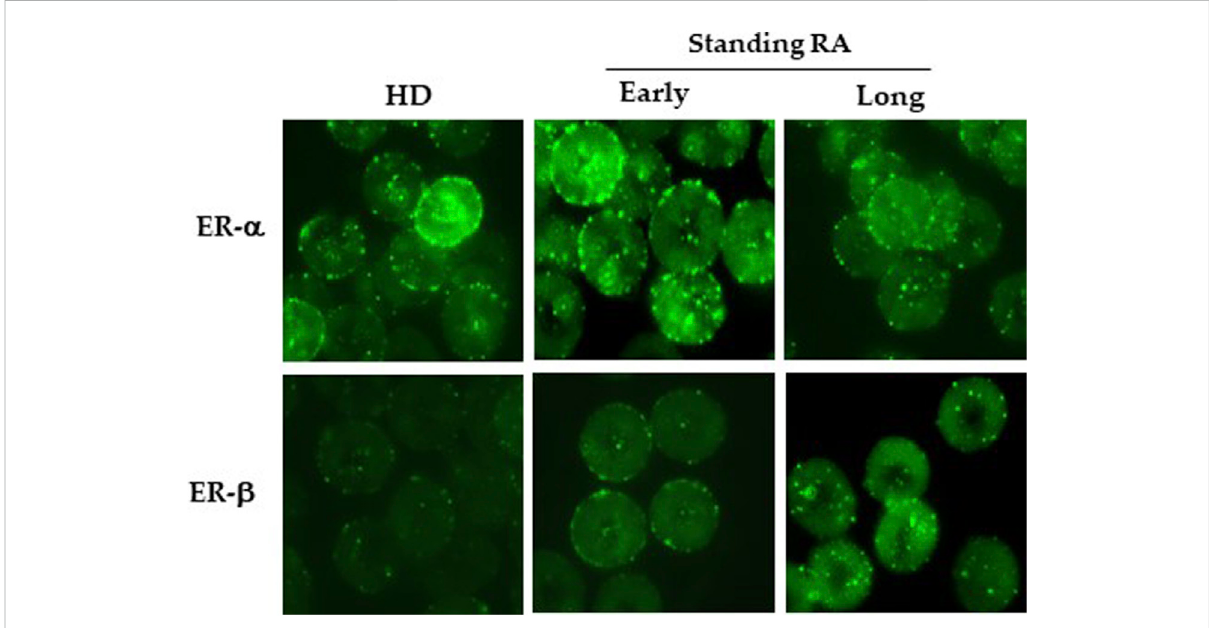
FIGURE 2 Localization of ERs in RBCs. Upper panels: Micrographs obtained by static cytometry showing ER- α distribution in RBCs from a representative HD, a representative early- and a representative long-standing RA patient. Lower panels: Micrographs obtained by static cytometry showing ER- β distribution in RBCs from a representative HD, a representative early- and a representative long-standing RA patient.